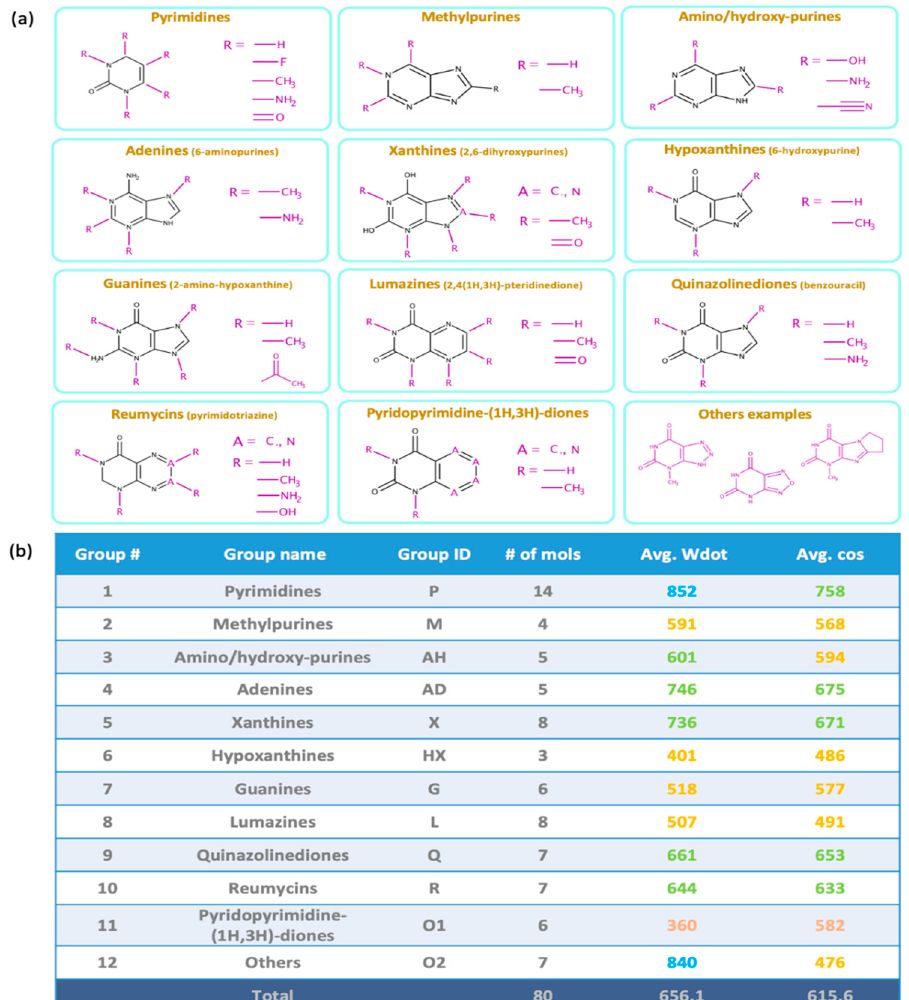
Figure 3. ( a ) Categorization of 80 purines and pyrimidines by structural subclasses. ( b ) MS similarity purine and pyrimidine subclasses matching QCEIMS predicted spectra against experimental spectra. Colors indicate excellent matches (>800, blue), good (>600, green), fair (>400, yellow) and poor (<400, red) similarity scores.